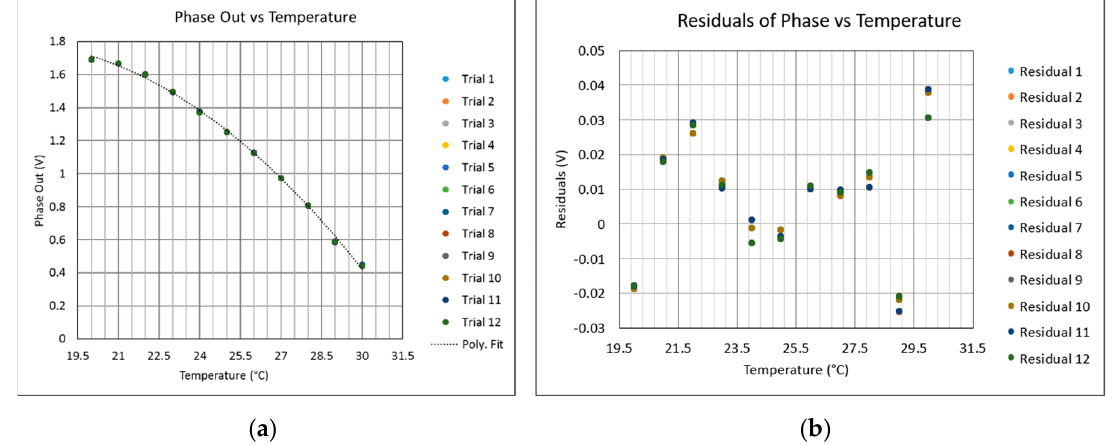
Figure 9. Results of 20 to 30 °C range in 1 °C steps ( a ) Phase output vs. temperature; ( b ) Residual plot.